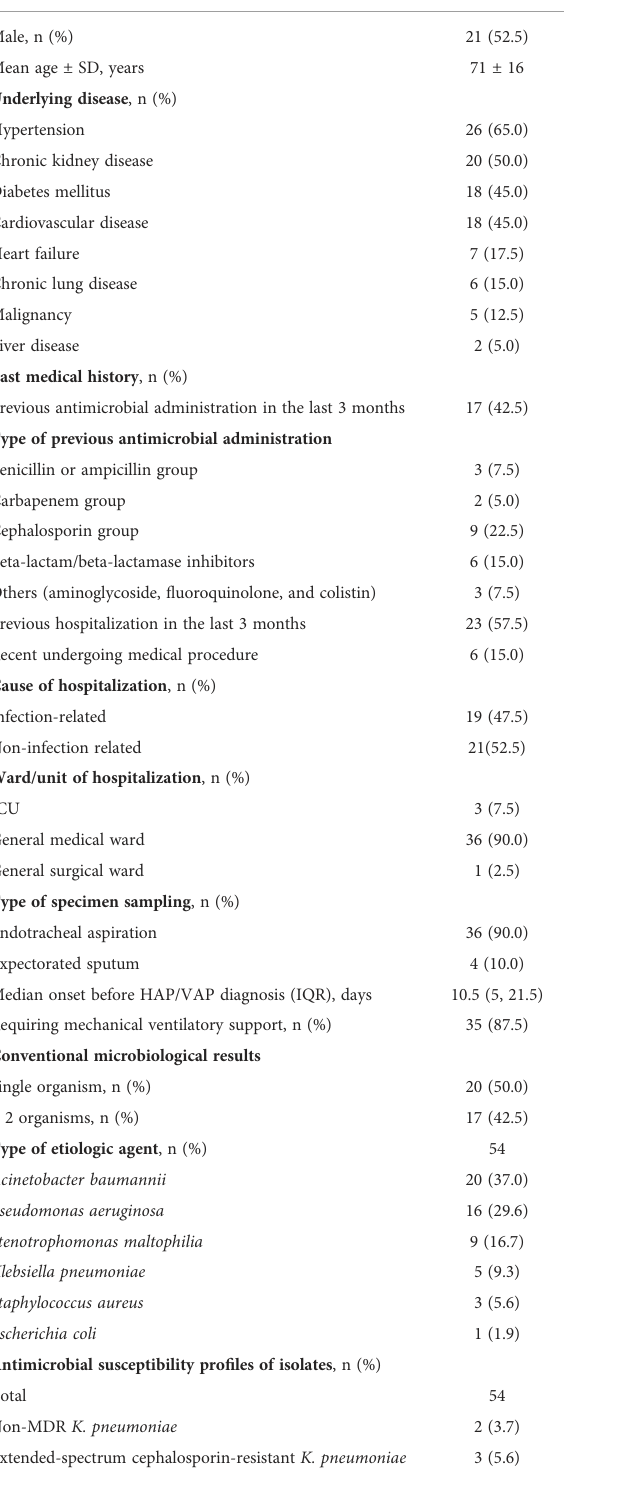
BFPP assay ( k < 0.00). Of 20 A . baumannii , two of three non-